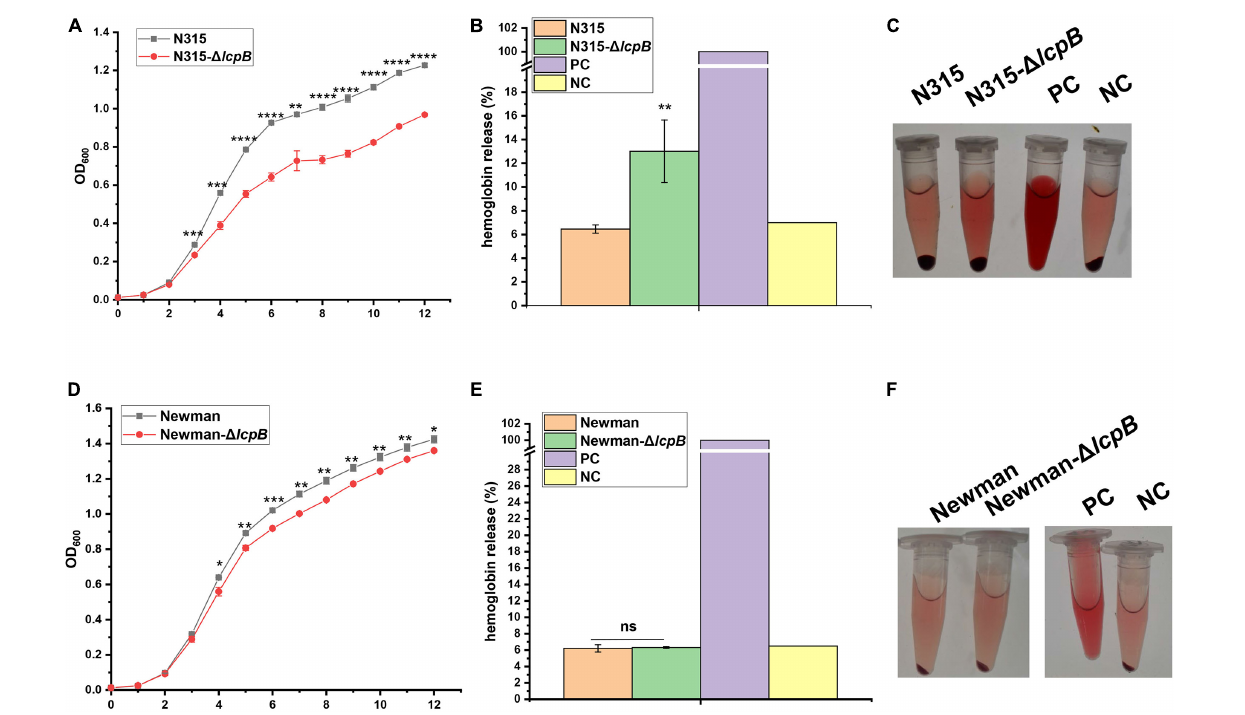
FIGURE 5 | Regulation of LcpB is strain-specific and agr -independent. (A) Growth of the N315 wild-type and lcpB mutant strains. The results were obtained from three independent experiments performed in triplicates. Data is presented as the mean ± SD or SEM. Two-tailed Student’s t -test is used for the comparison of statistical significance. The wild-type strain was used as the reference. * p < 0.05; ** p < 0.01; *** p < 0.001, **** p < 0.0001. (B) Hemolytic activity in the N315 wild-type and lcpB mutant strains was determined at 543 nm by incubating samples with 10% sheep red blood cells for 2.5 h. PBS and ddH 2 O were used as the negative control and the positive control, respectively. Data is presented as the mean ± standard deviation. Two-tailed Student’s t -test is used for the comparison of statistical significance. * p < 0.05, ** p < 0.01. (C) Photograph for hemolytic activity in the N315 wild-type and lcpB mutant strains. (D) Growth of the Newman wild-type and lcpB mutant strains. The results were obtained from three independent experiments performed in triplicates. Data is presented as the mean ± SD or SEM. Two-tailed Student’s t -test is used for the comparison of statistical significance. The wild-type strain was used as the reference. * p < 0.05; ** p < 0.01; *** p < 0.001. (E) Hemolytic activity in the Newman wild-type and lcpB mutant strains was determined at 543 nm by incubating samples with 10% sheep red blood cells for 2.5 h. PBS and ddH 2 O were used as the negative control and the positive control, respectively. Data is presented as the mean ± standard deviation. Two-tailed Student’s t -test is used for the comparison of statistical significance. ns, no significance. (F) Photograph for hemolytic activity in the Newman wild-type and lcpB mutant